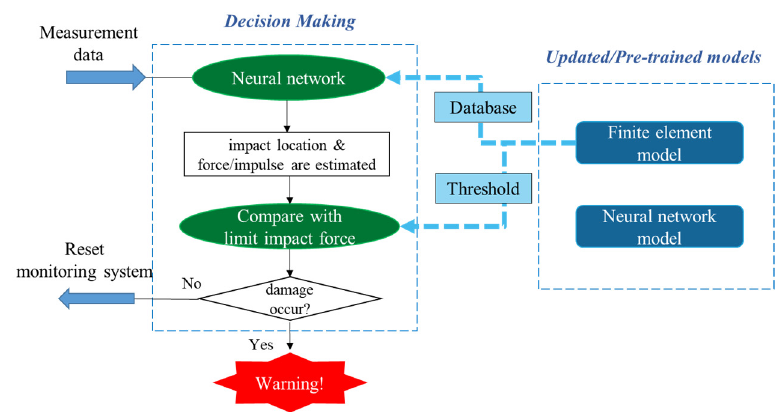
Figure 6. AI-based rapid condition assessment